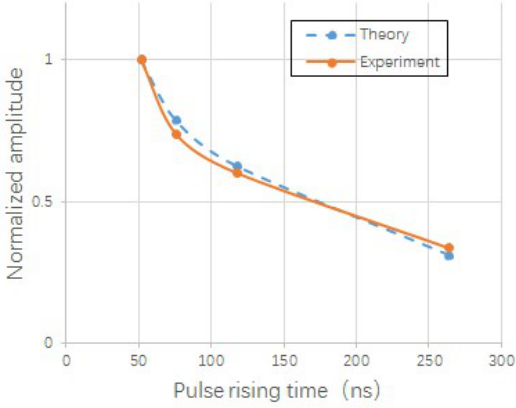
Figure 13. Theoretical calculated and experimentally tested “relationship between Trichel pulse rising edge and radiation signal amplitude”.